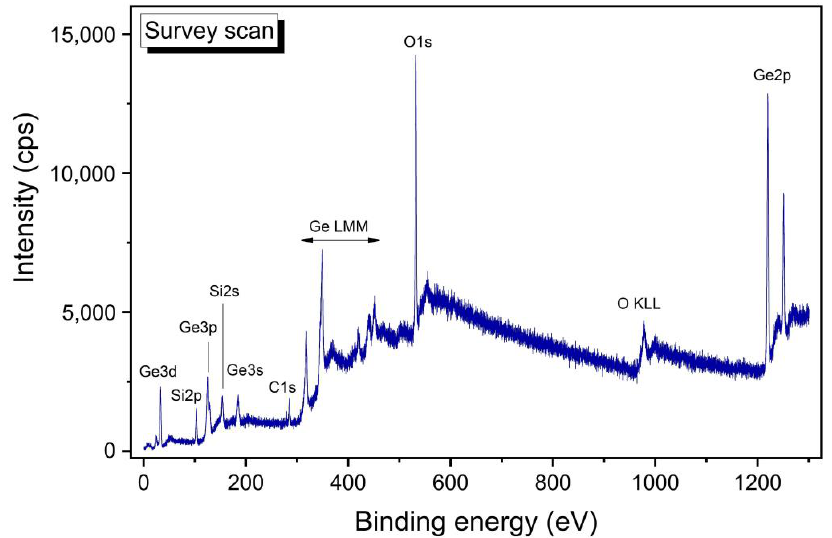
Figure 2. Survey spectrum of X-ray photoelectrons for a film obtained by the co-evaporation of GeO 2 and SiO 2 powders. and SiO 2 powders.